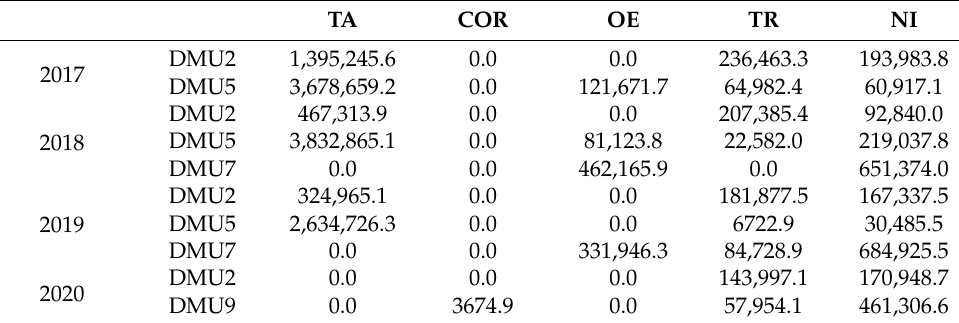
Table A2. Slacks of inefficiency DMUs